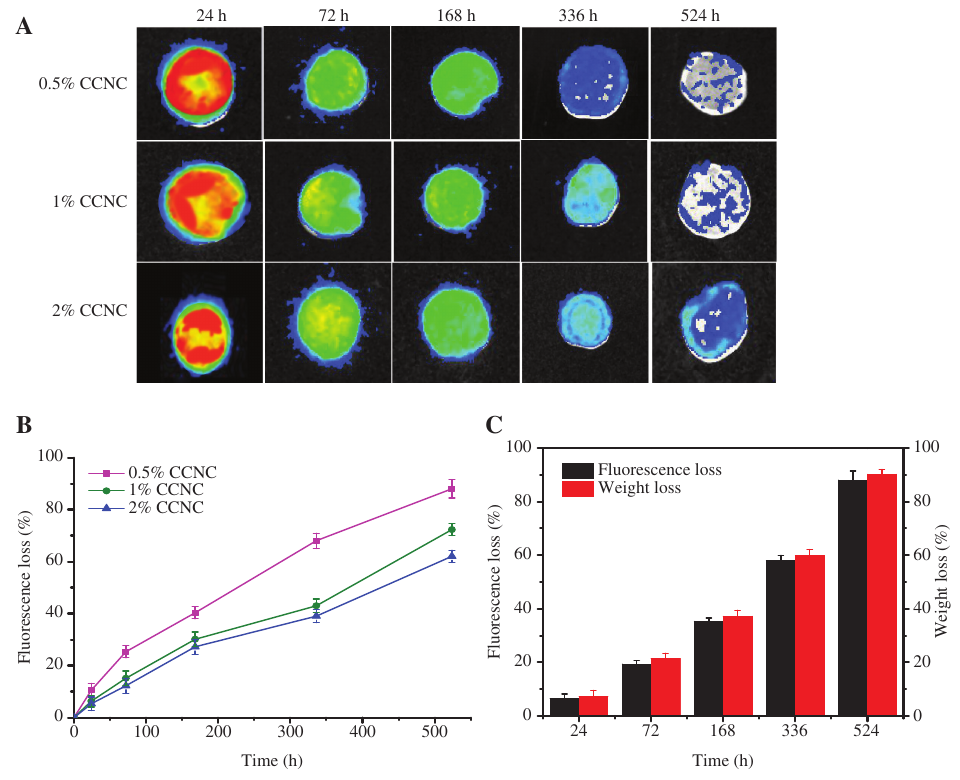
Figure 8: In vitro degradation of DEX/CCNC/MPDA-TPE hydrogels cultured with NIH-3T3 cells. (A) Fluorescent image of different hydrogels over time. (B) Quantitative fluorescence reduction of different hydrogels over time. (C) Correlation of DEX/CCNC/MPDA-TPE hydrogel degradation quantified by applying noninvasive visual determination and invasive gravimetric